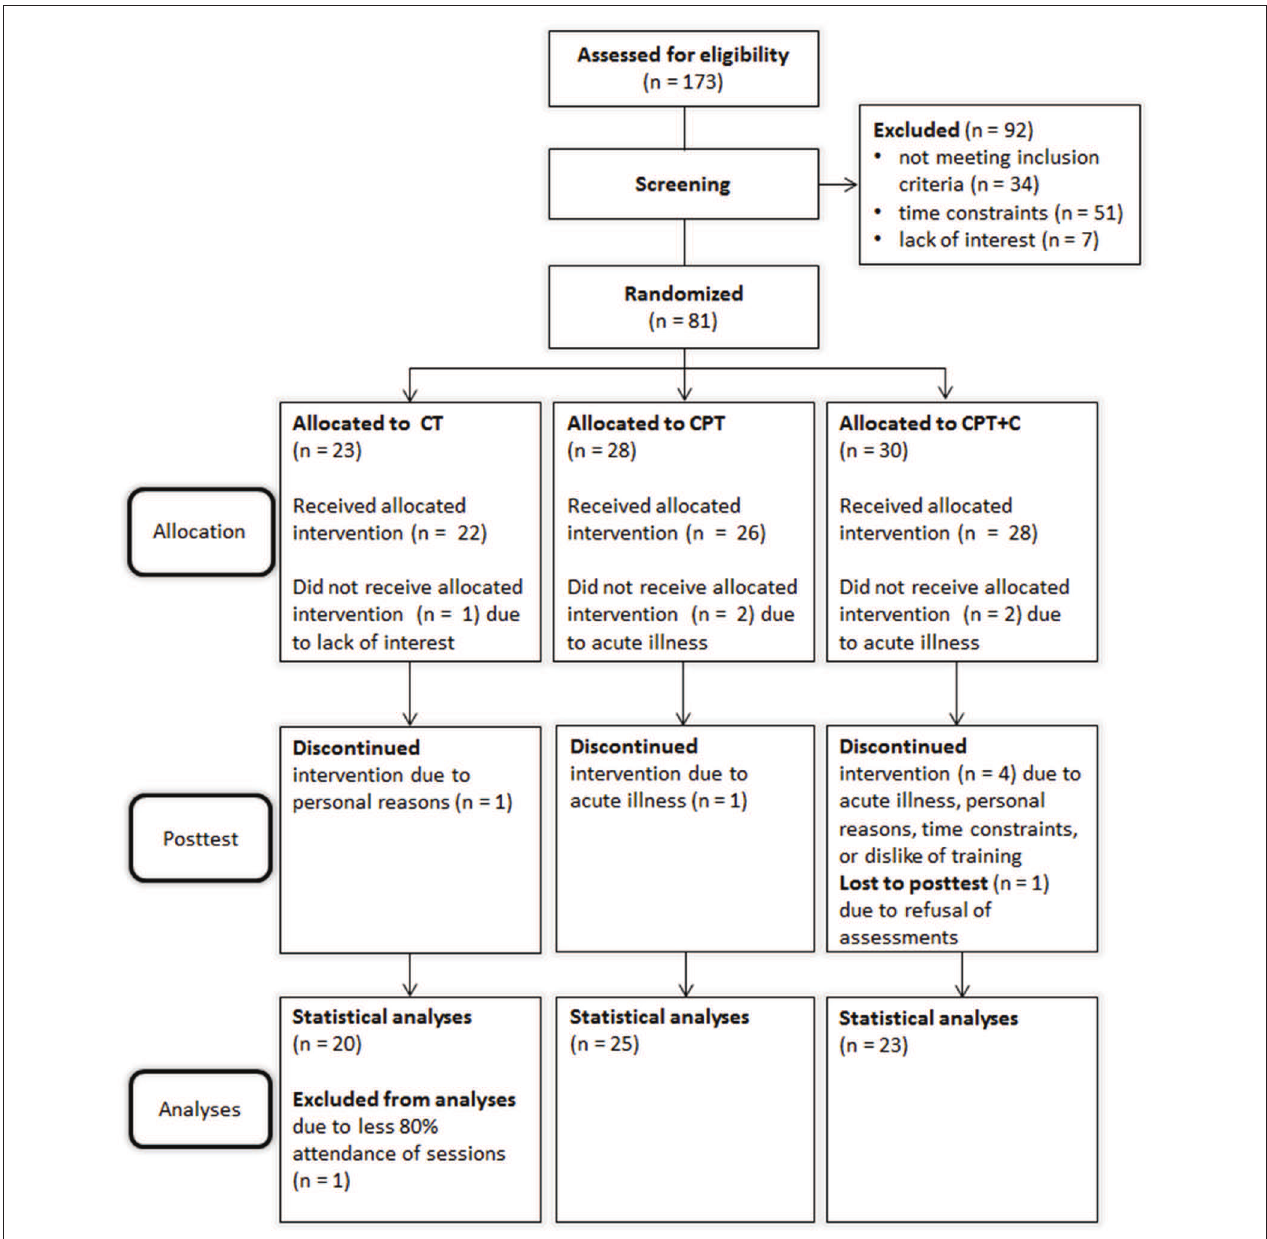
FIGURE 1 | Flow of participants through the study. CPT, cognitive-physical training; CPT + C, cognitive-physical training with counseling; CT: cognitive training.